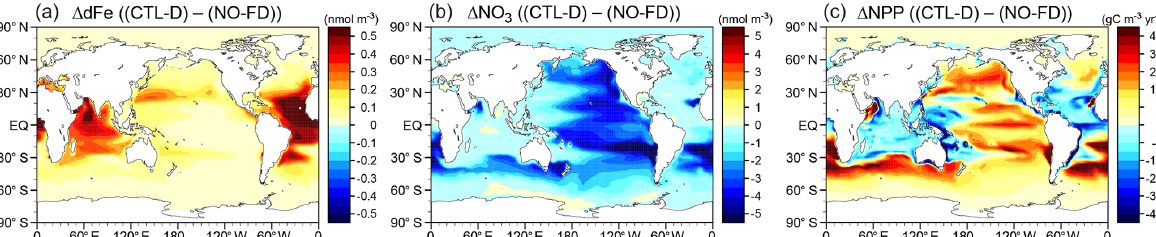
Figure 15. Changes in (a) surface dissolved iron, (b) nitrate, and (c) NPP driven by dissolved iron input from dust (CTL-D –